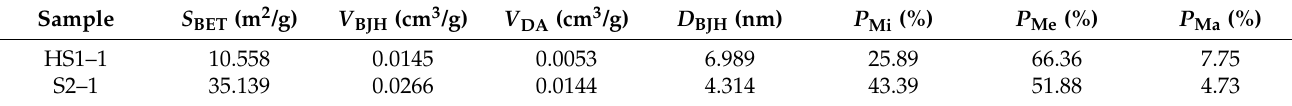
Table 2. Pore structure parameters of the studied